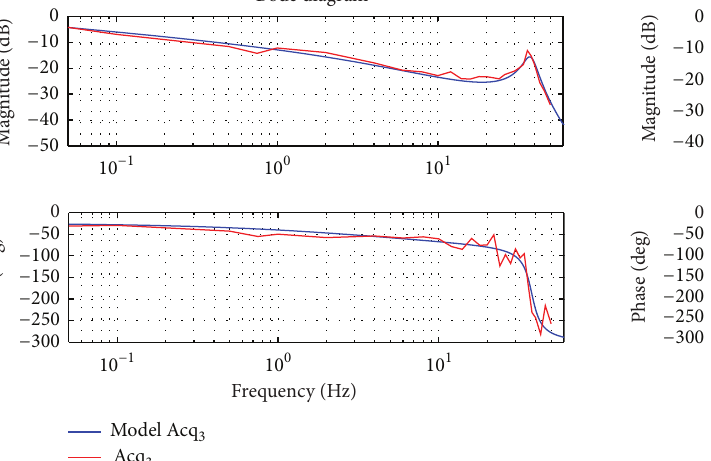
Figure 6: Magnitude and phase of the model on Acq 3 data via GAs.